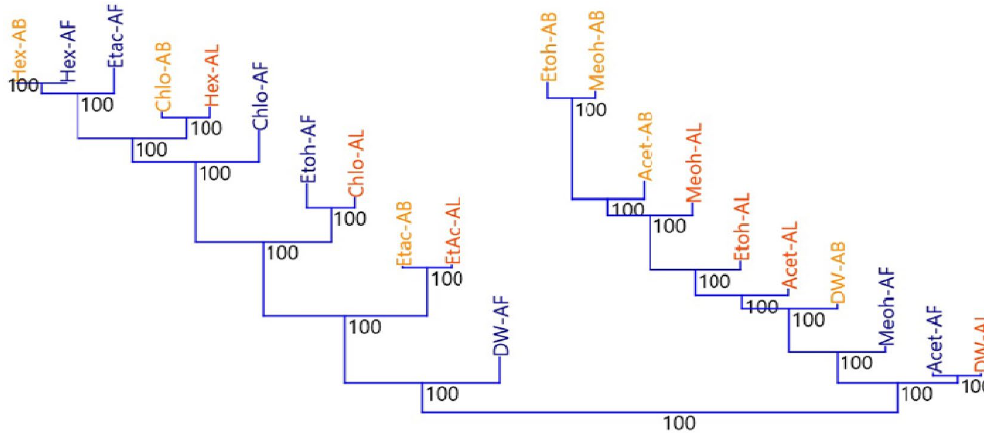
Figure 2. Association pattern between solvent extracts of T. arjuna based on the antioxidant potential. Two variables are included in the analysis: the bootstrap value and the distribution similarity index. Figure showing two main cluster and thereafter each custer divided into subcluters based on their antioxidant potential. Cluster one includes mainly polar and polar aprotic solvent extracts except DW-AF and Etoh-AF. Categorically, Etoh-AB and Meoh-AB showed same pattern, followed by Acet-AB > Meoh-AL > Etoh-AL > Acet-AL > DW-AB > Meoh-AF > Acet-AF > DW-AL. In second cluster Hex-AB, Hex-Af and Etac-AF showed same pattern of distribution.